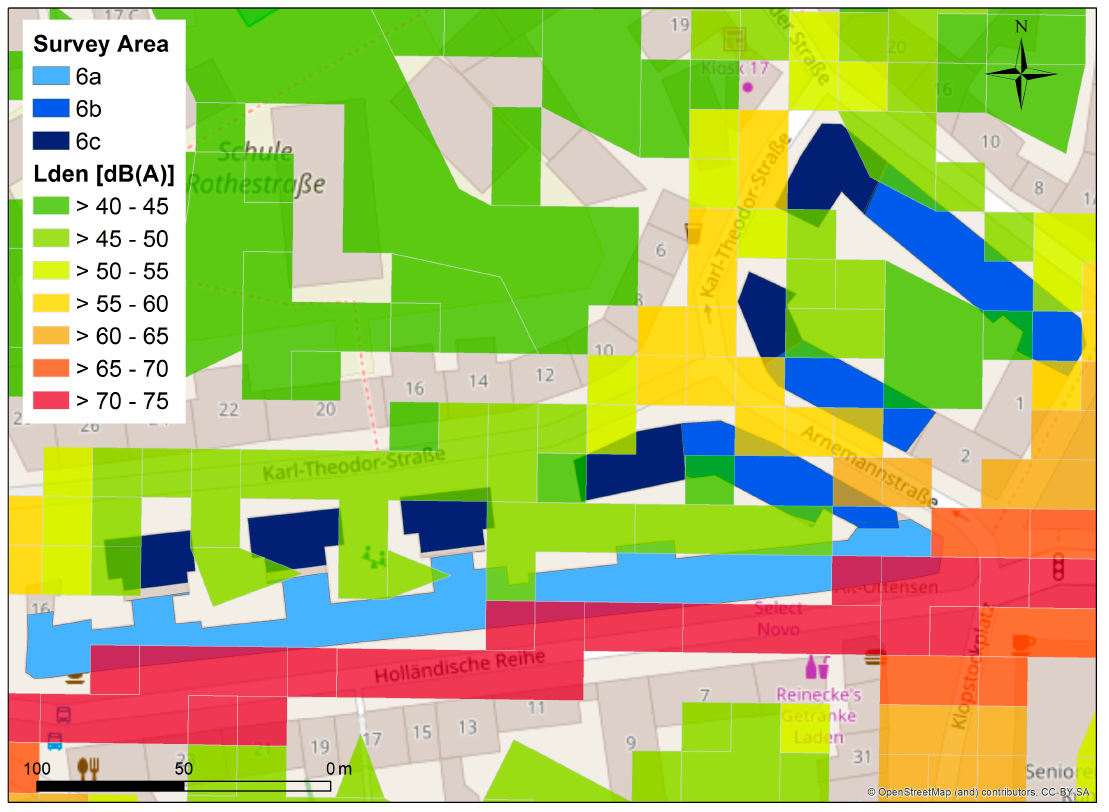
Figure 3. Traffic noise levels according to the noise map of Hamburg around survey area 6.